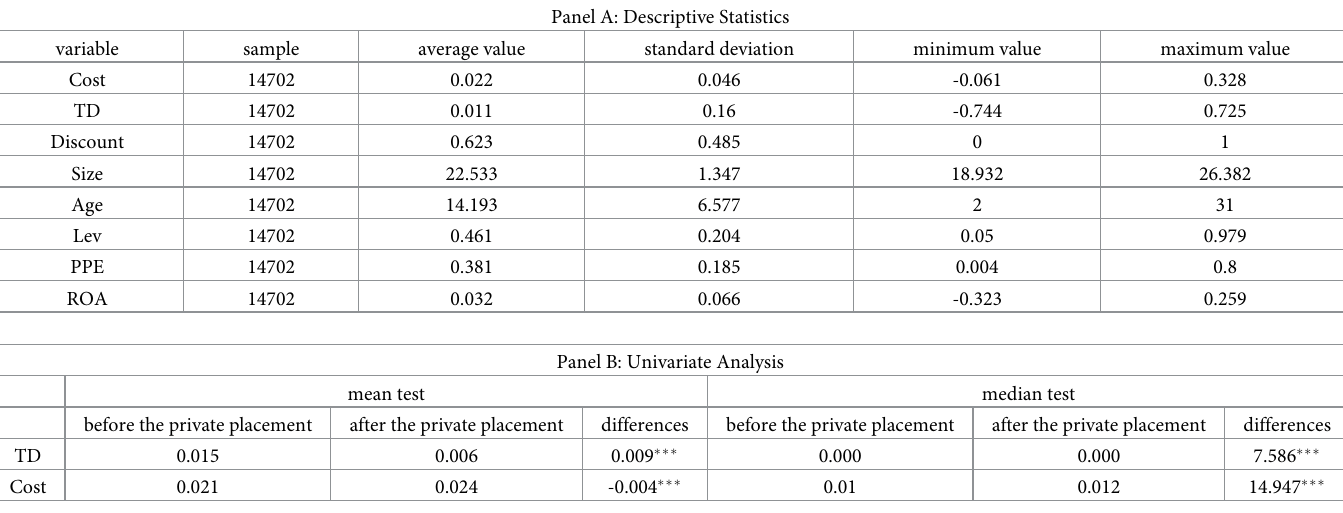
Table 2. Descriptive statistics and univariate